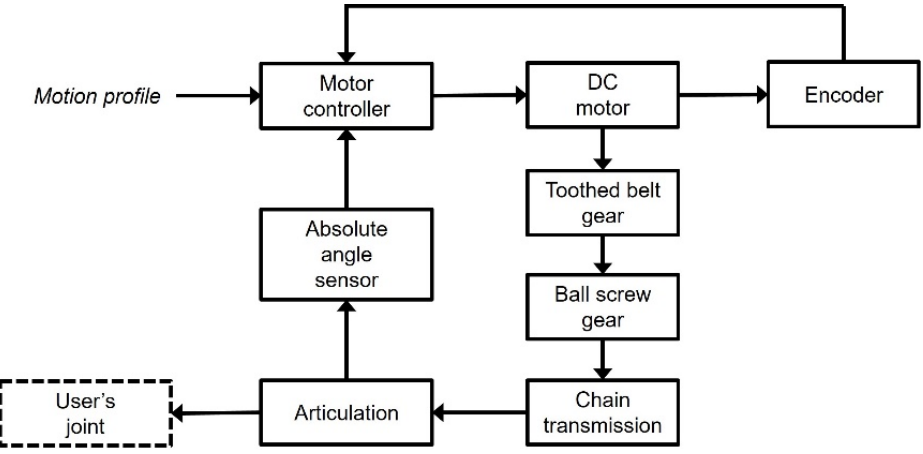
Figure 6. Block diagram of the drive system.